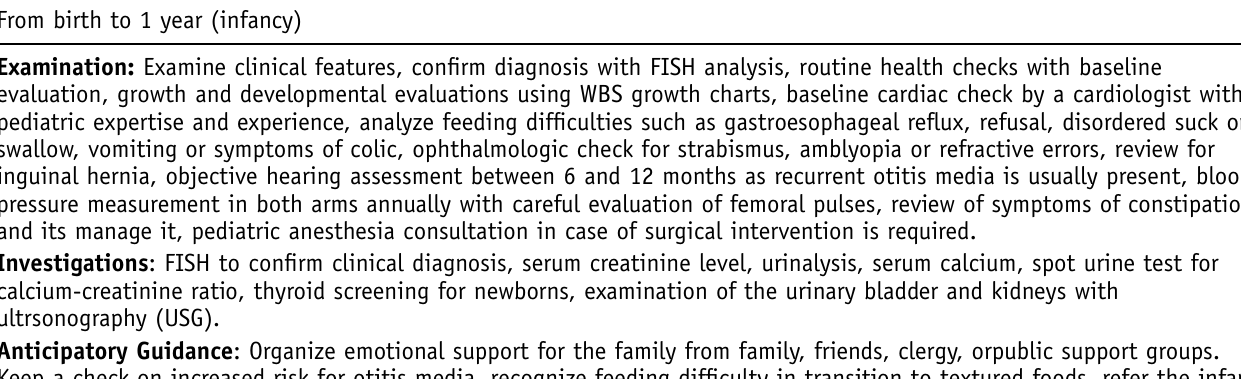
Table III. Guidelines for healthcare supervision of children through adulthood with